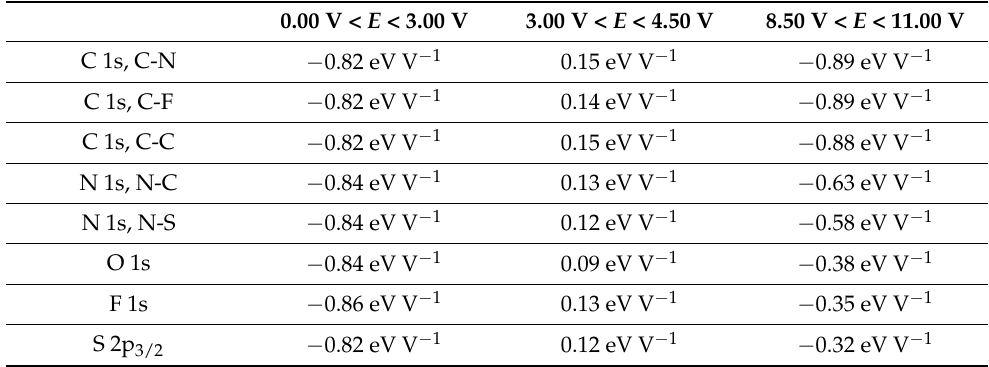
Table 1. Core-electron binding energy vs. Al electrode potential relationships for various Al-electrode potential ranges measured with in situ X-ray photoelectron spectroscopy. 0.00 V < E < 3.00 V 3.00 V < E < 4.50